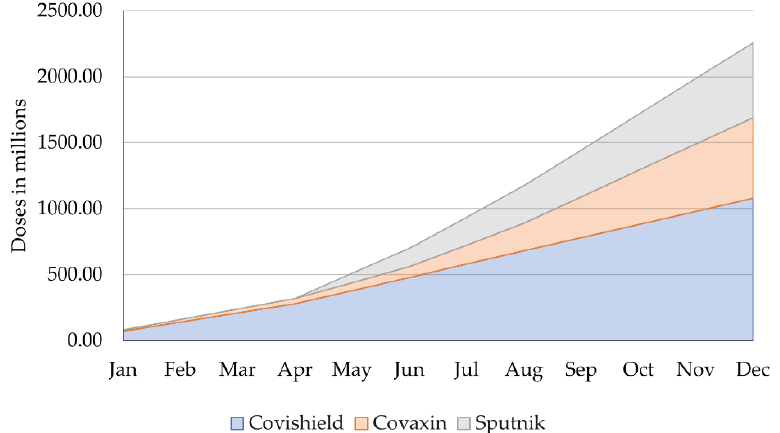
Figure 2. Cumulative production capacity by vaccine type (incl. scale-up). Own illustration, data